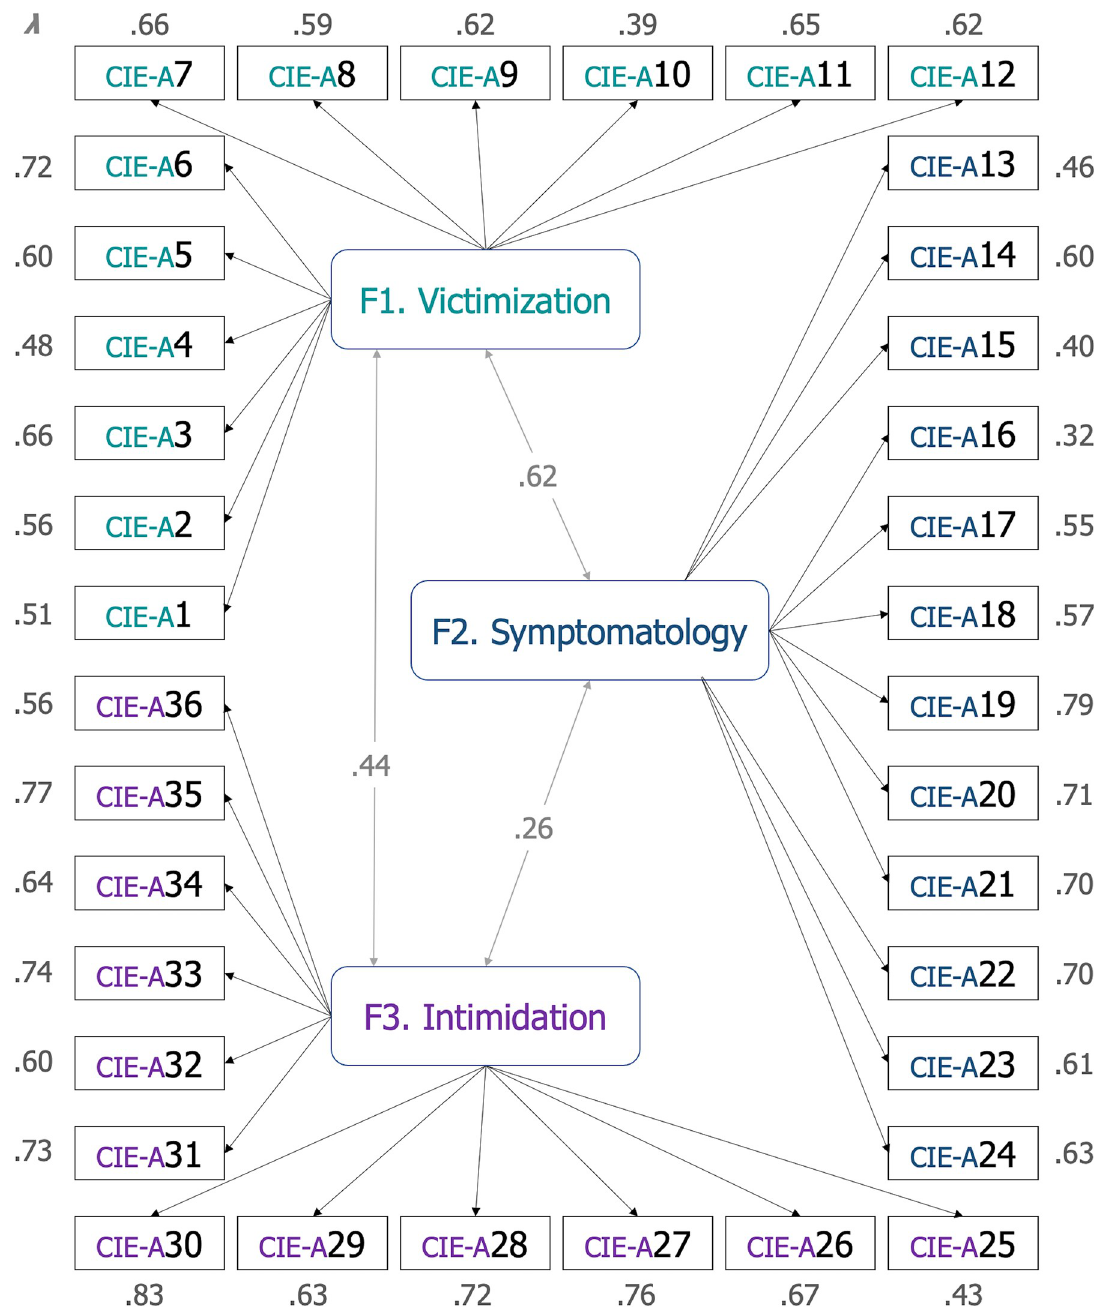
Fig 1. CIE-A structure. Standardized parameter estimates and factor correlations. Notes : All standardized estimates were p < .001; the numbers within squares represent the original numbers of the items in the CIE-A (as shown in Table 3). Cronbach’s alpha estimates were all above the usual α = .700 criteria, advised in several spe- cialized sources (Morera & Stokes, 2016), which denotes a suitable internal reliability for all scales: .855 for Victimization (Factor 1); .867 for Symptomatology (Factor 2); and .901 for Intimidation (Factor 3).